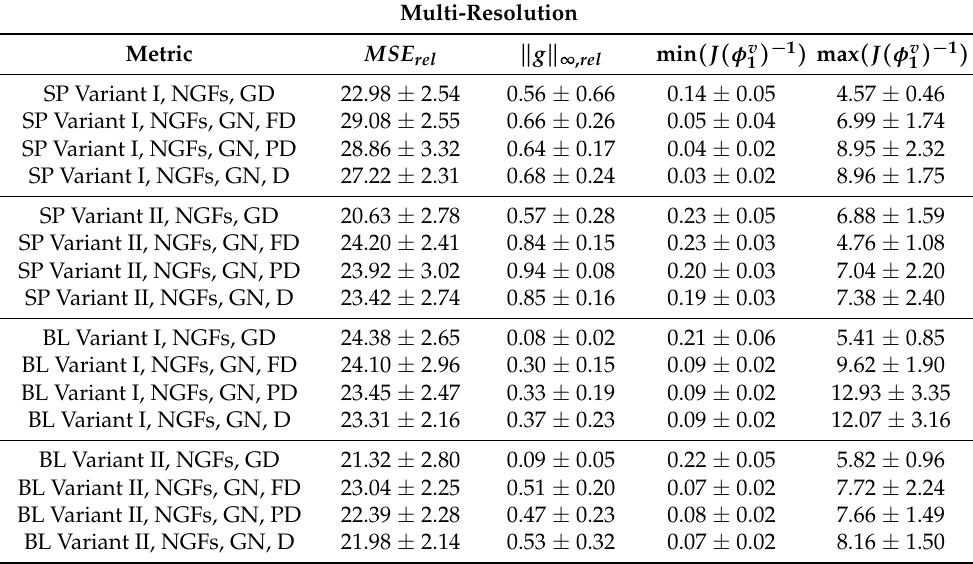
2 Id Λ ) : diagonal, penta- · · ), and the Jacobian g (cid:107) (cid:107) ∞ , rel ) − 1 1